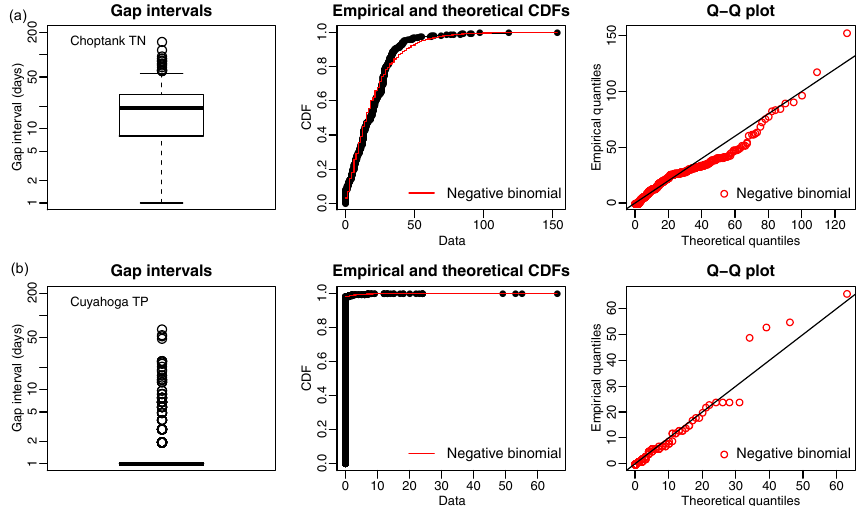
Figure 3. Examples of quantified sampling irregularity with negative binomial (NB) distributions: total nitrogen in Choptank River (a) and total phosphorus in Cuyahoga River (b) . Theoretical CDF (cumulative distribution function) and quantiles are based on the fitted NB distributions. See Table 1 for estimated mean and shape